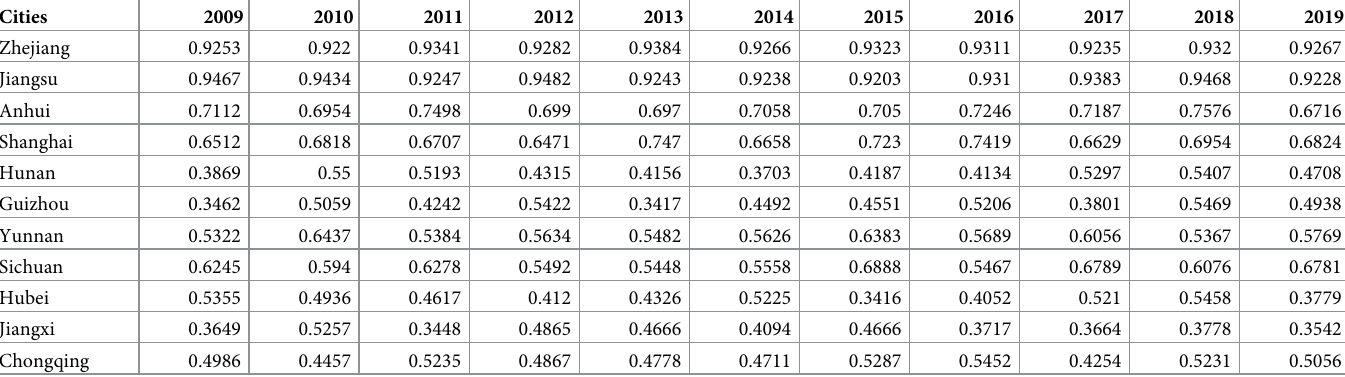
Table 4. Ecological systems comprehensive index value for various regions.